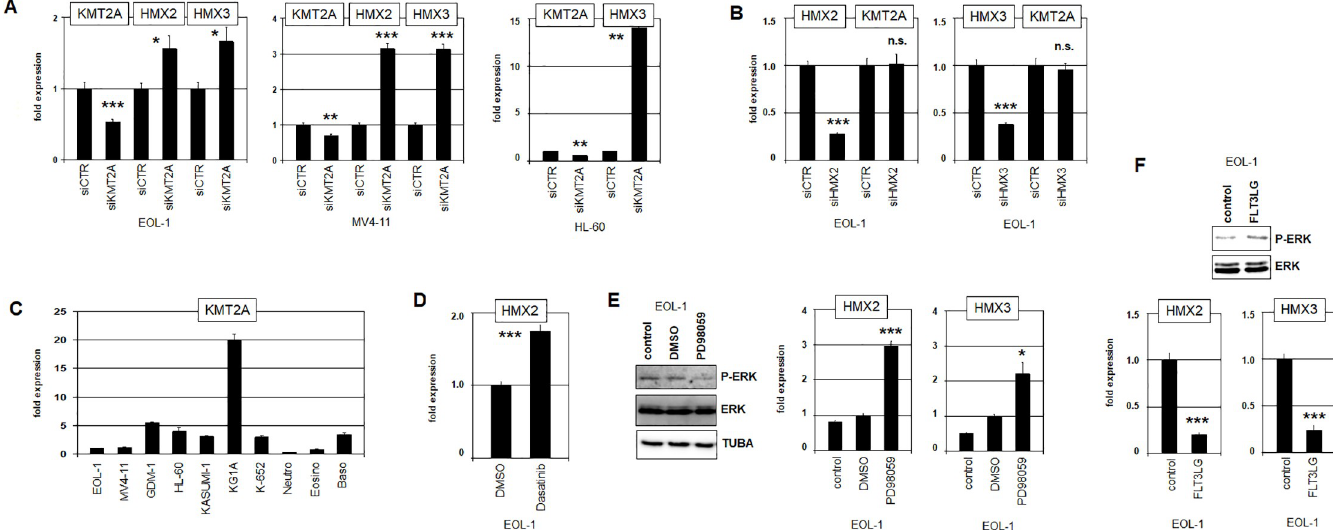
Fig 2. Regulation of HMX2 and HMX3 by KMT2A and ERK-signalling. (A) RQ-PCR analysis of EOL-1 (left) and MV4-11 (middle) treated for siRNA-mediated knockdown of KMT2A demonstrates raised expression levels of HMX2 and HMX3, indicating a repressive impact of KMT2A. This treatment resulted in enhanced expression of HMX3 in HL-60 cells which did not express HMX2 (right). Asterisks indicate calculated p-values obtained by t-Test analysis of controls (siCTR) and siRNA-targeted knockdown. (B) RQ-PCR analysis of KMT2A of EOL-1 cells treated for siRNA-mediated knockdown of HMX2 (left) and HMX3 (right) showed unaltered KMT2A expression levels, discounting any regulatory impact. (C) Quantification of KMT2A transcripts in AML cell lines and primary granulocytes showed low expression levels in EOL-1, MV4-11 and in eosinophils. (D) RQ-PCR analysis of HMX2 showed elevated expression levels in EOL-1 cells treated with PDGFRA- inhibitor dasatinib. Asterisks indicate calculated p-values obtained by t-Test analysis of controls (DMSO) and pharmacological treatments. (E) Treatment of EOL-1 cells with ERK-inhbitor PD98059 resulted in reduced levels of phospho-ERK as analyzed by Western blot (left), and in elevated transcript levels of HMX2 (middle) and HMX3 (right) as analyzed by RQ-PCR. (F) Treatment of EOL-1 cells with ERK-activator FLT3LG resulted in elevated levels of phosphorylated ERK (above) and in reduced transcript levels of HMX2 and HMX3 (below).